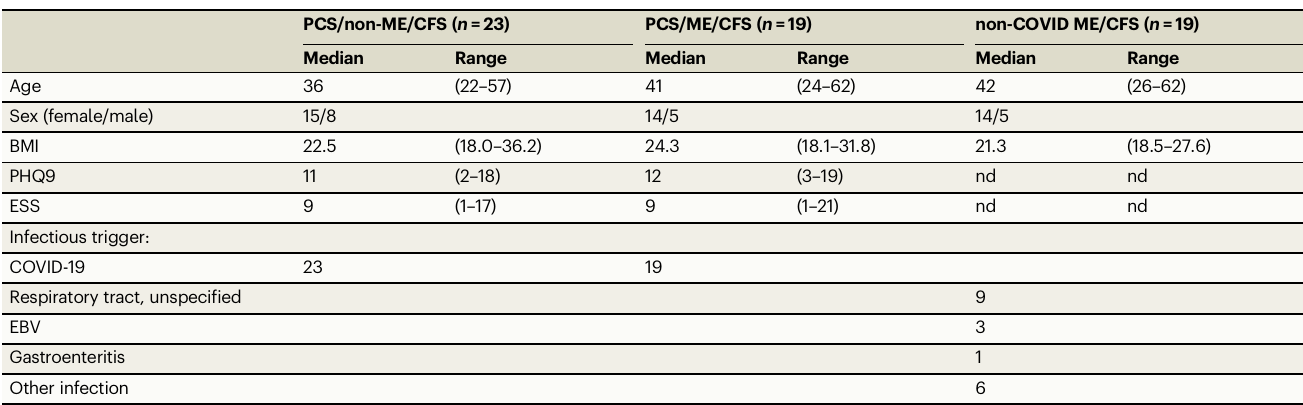
Table 1 | Demographic and baseline clinical